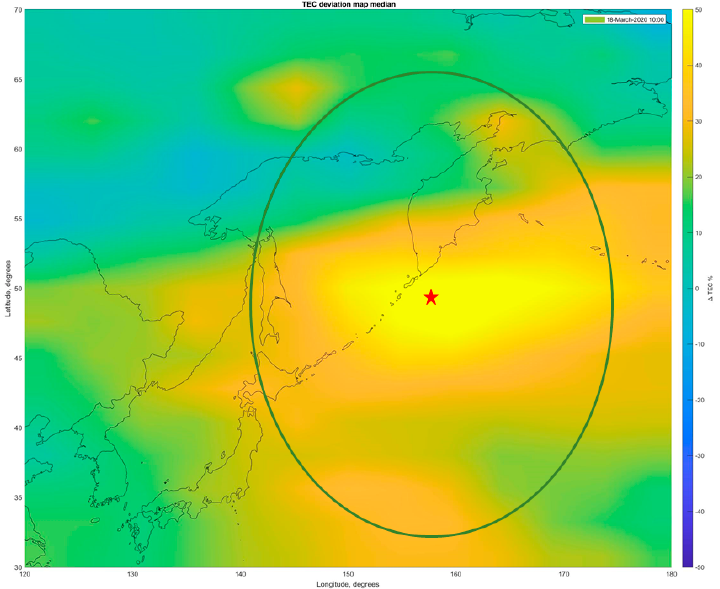
Figure 14. Differential TEC map registered 6 days before the M7.6 earthquake east of the Kuril Islands on 25 March 2020. Red star—position of the earthquake epicenter.